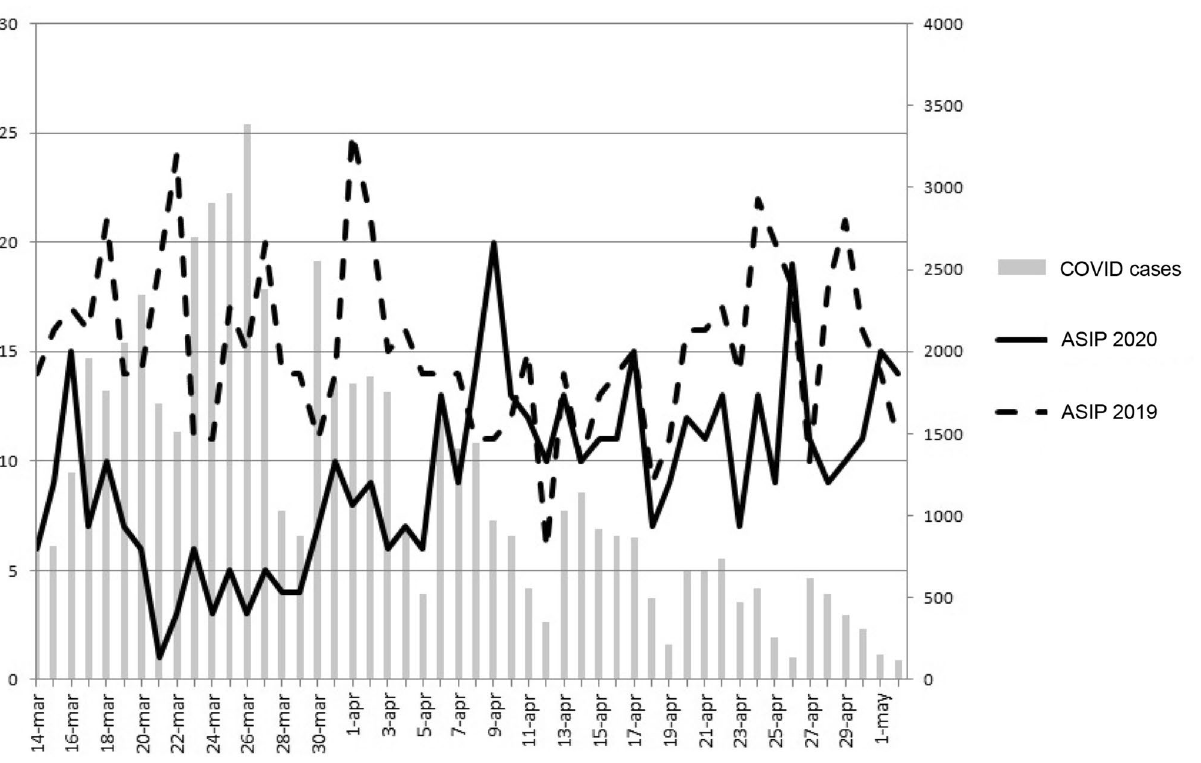
Figure 1. Study timeline comparing daily number of patients of 2020 with 2019 and the number of COVID-19 cases diagnosed each day (This data refers to the Community of Madrid only). COVID-19 coronavirus disease